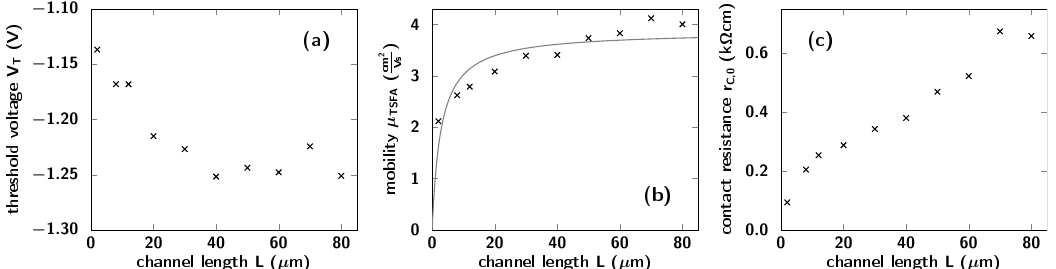
Figure 4. Dependence of the transistor parameters extracted using the TSFA for the theoretical transistor model underlying the conventional TLM on the channel length L . In ( a ), it can be seen that the threshold voltage V T shows only a very small dependence on the channel length. Panel ( b ) indicates that the dependence of the charge-carrier mobility µ TSFA on the channel length L (symbols) is not properly described by the equation µ TSFA = µ TLM L / ( L + L T ) (solid line), with L T being the transfer length. In ( c ), the distinct linear increase of the contact resistance r C ,0 = r S ,0 + r D ,0 with increasing channel length L cannot be explained at all. As a consequence, the model does not pass the second